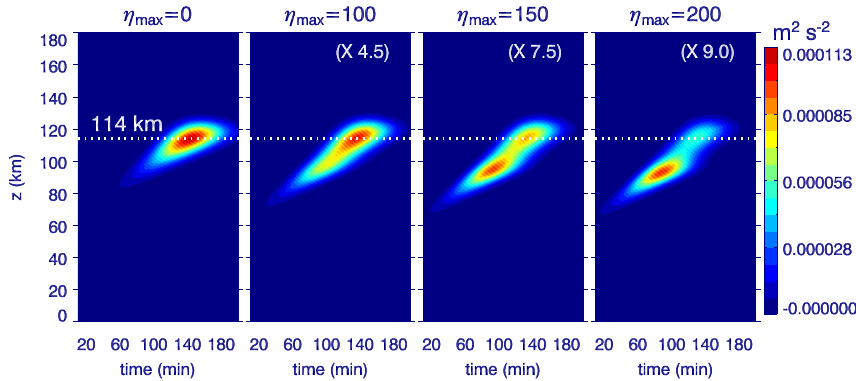
Fig. 8. Temporal evolutions of the momentum flux profiles for the GW with initial λ z = 5km propagating through the isothermal atmosphere (shown as the solid line in Fig. 2) with Pr = 1 and η max = 0, 100, 150, 200m 2 s − 1 , respectively. The scaling factors increase from left to right. Dotted lines show the altitude z = 114km, which is the momentum deposition height for the case without eddy diffusion.